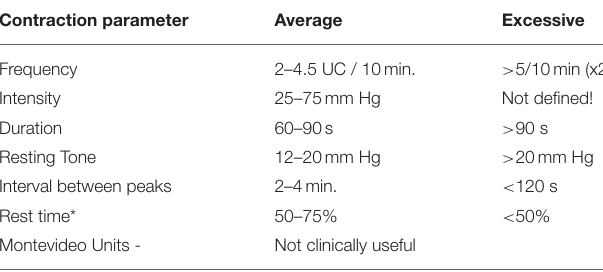
TABLE 3 | Uterine activity